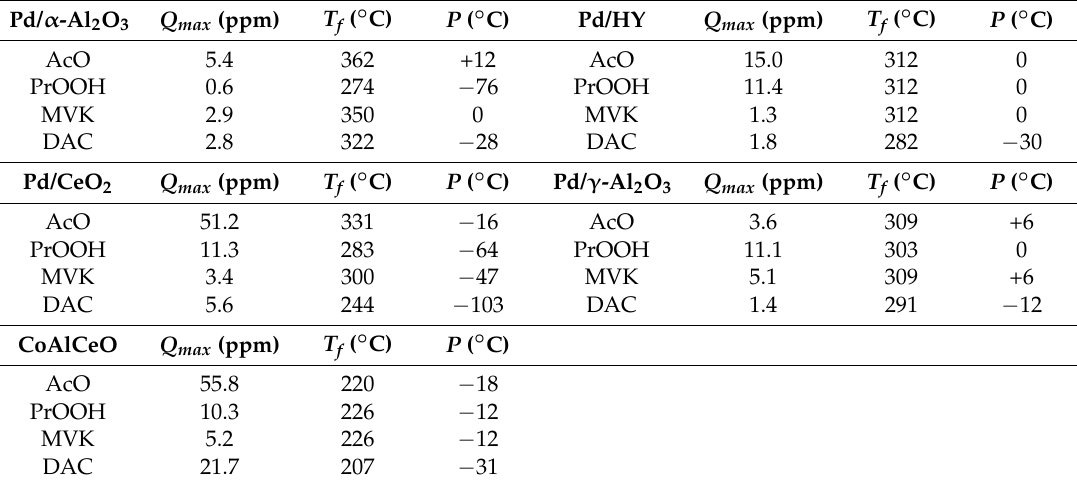
Table 4. Parameters characterizing the emission profiles of MEK